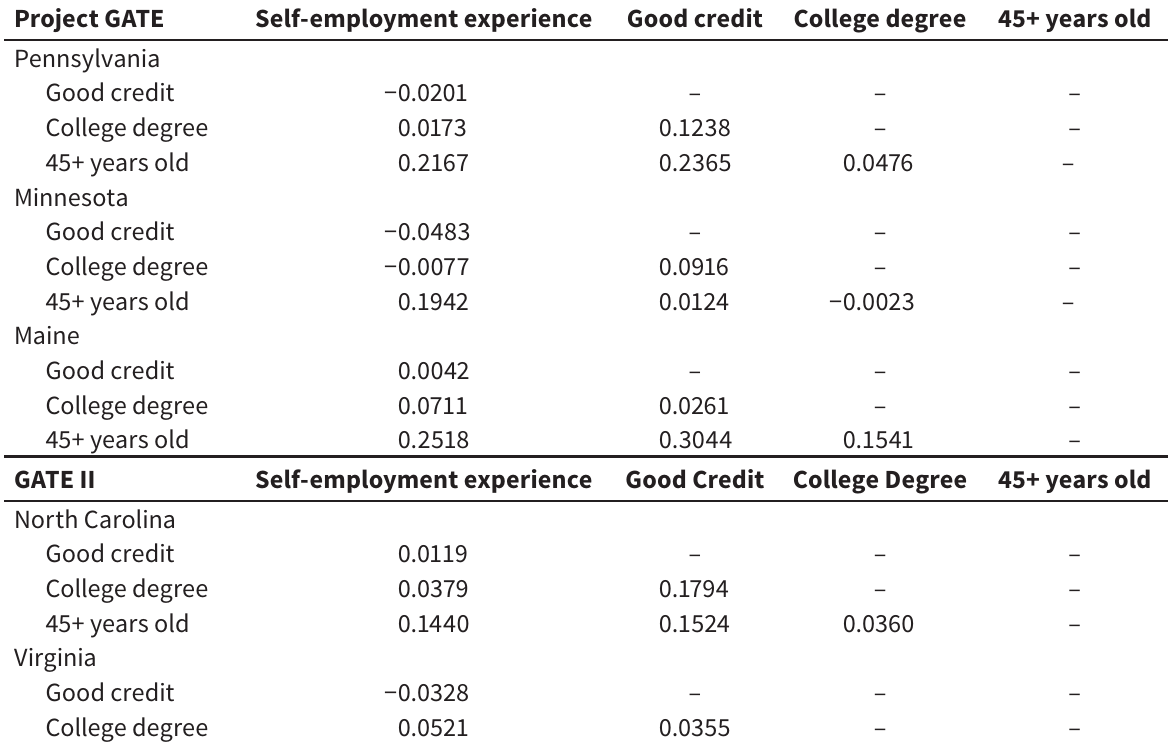
Correlations of key characteristics, treatment